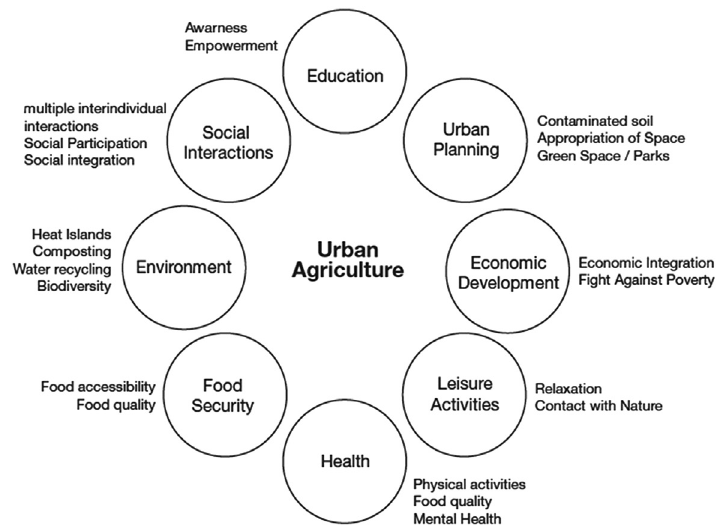
Fig. 3. Multidimensionality of urban agriculture. Source: Duchemin et al.